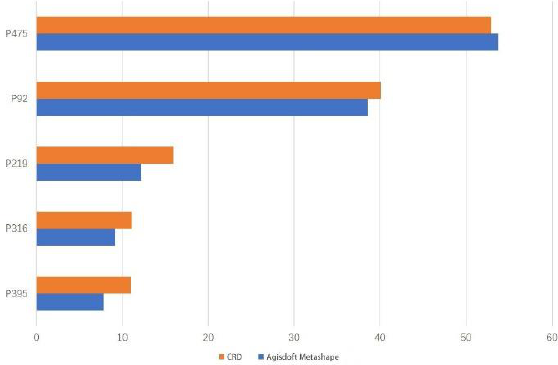
Fig.3 The calibration result of dataset P92 between CRD and Table.2 The relationship between CRD and the optimal radial distortion model